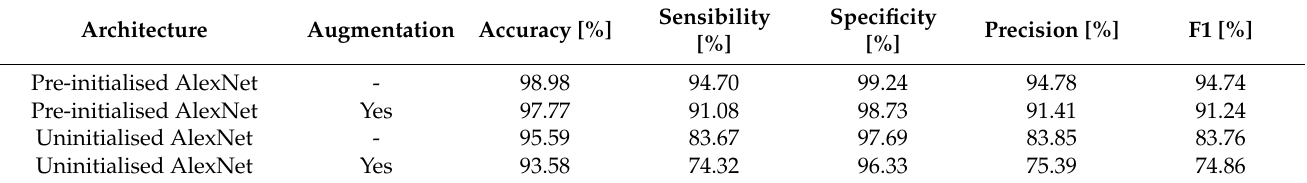
Table 6. AlexNet training